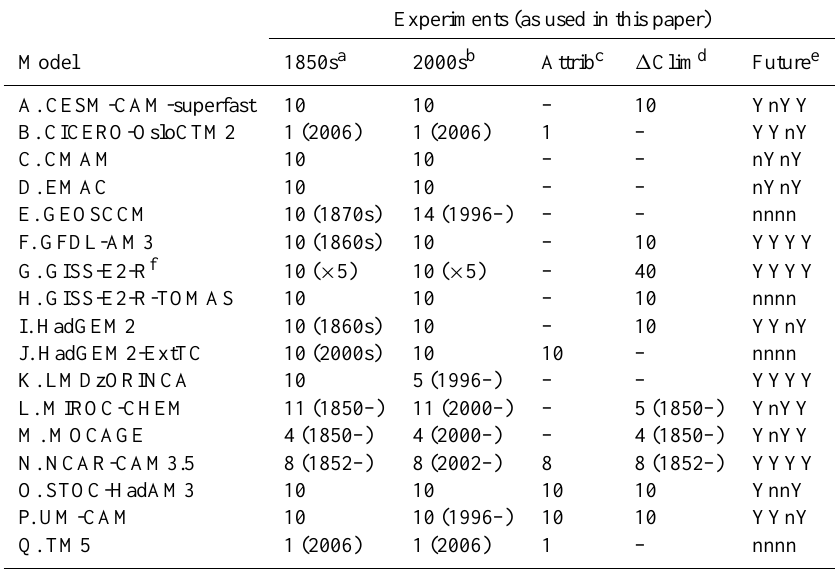
Table 1. Models and experiment run lengths (in years). All models ran with emissions for the 1850s and 2000s; the years specified correspond to the years specified for the climate (SST/SIC).